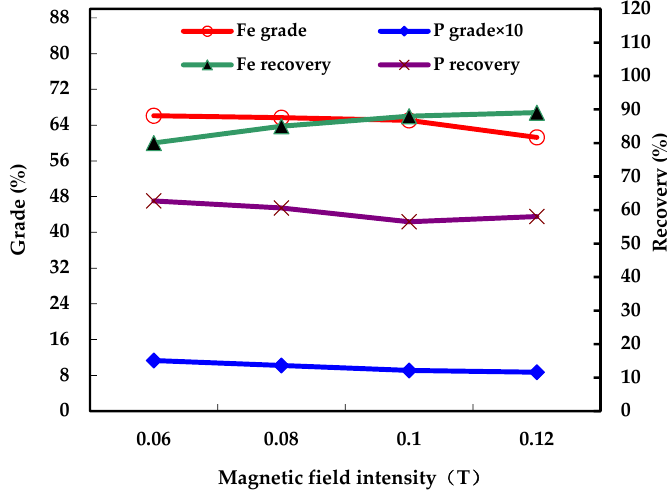
Figure 3. E ff ects of magnetic-field intensity on performance of the magnetic Figure 3. Effects of magnetic-field intensity on performance of the magnetic separation.